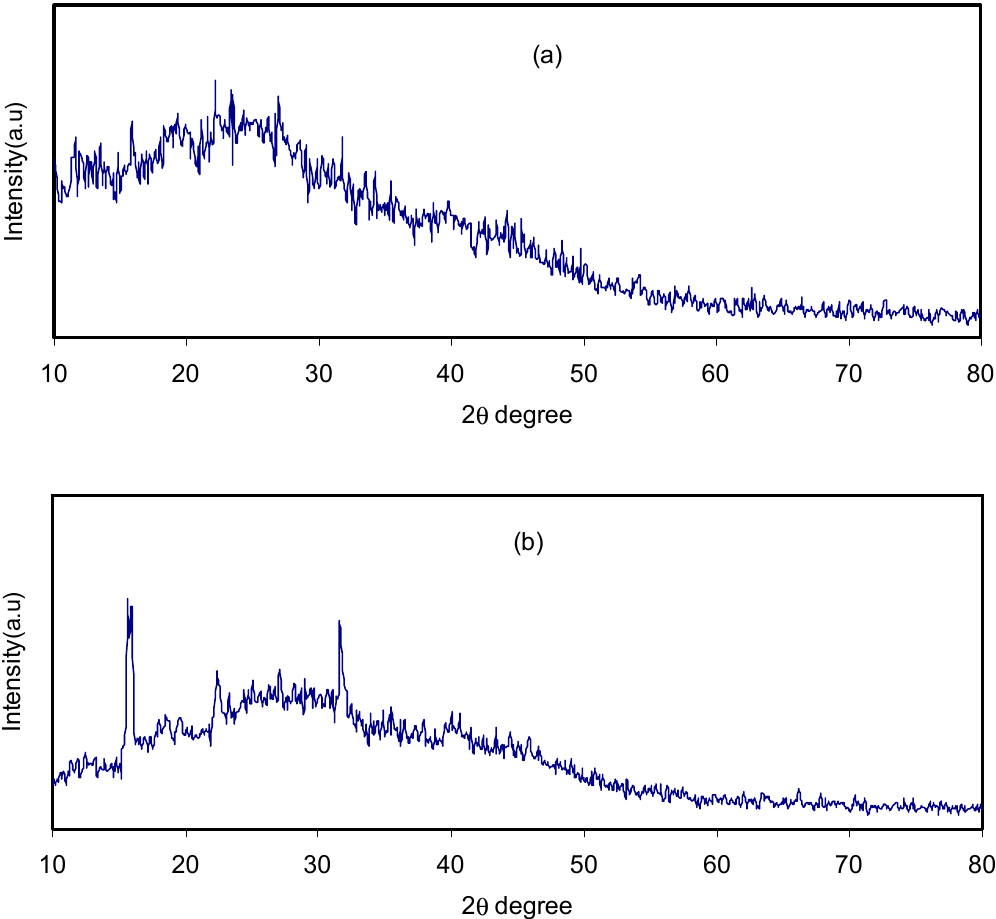
Figure 2. XRD pattern for ( a ) CSDX2 and ( b ) CSDX2 blend electrolyte samples at ambient